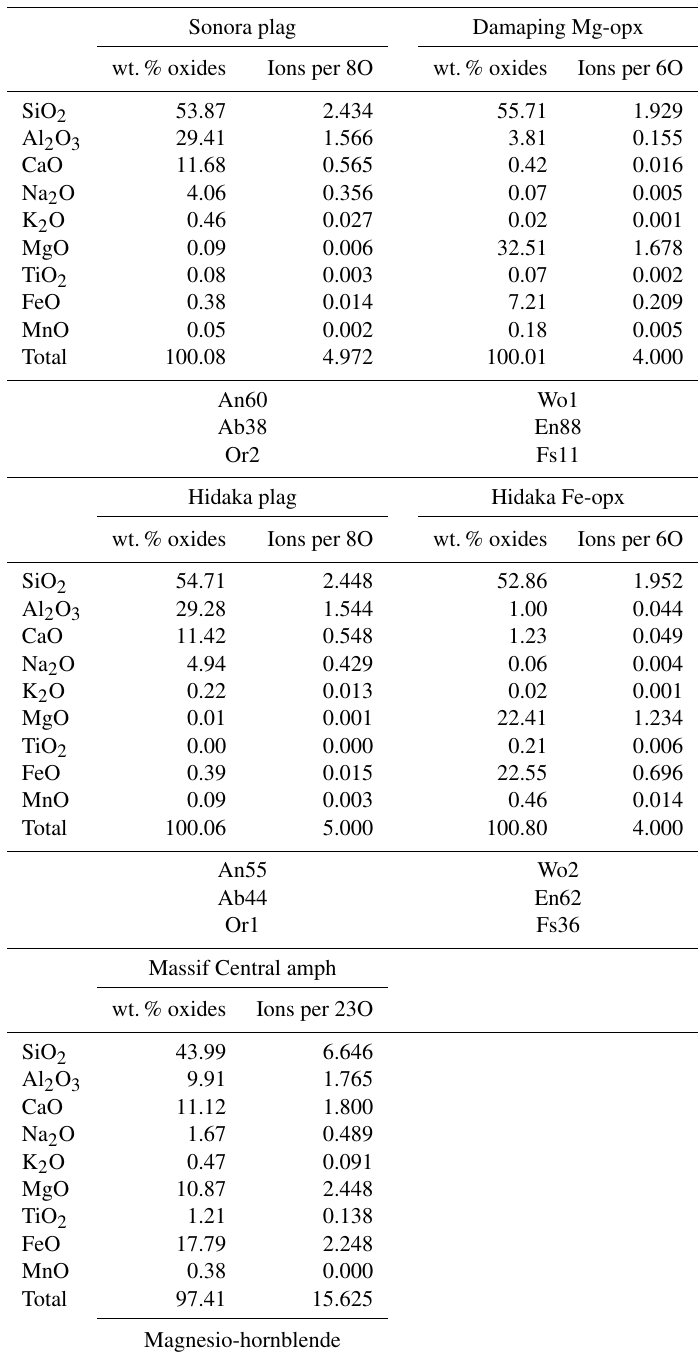
Table 1. Chemical compositions of plagioclase, pyroxene, and amphibole starting materials. Sonora